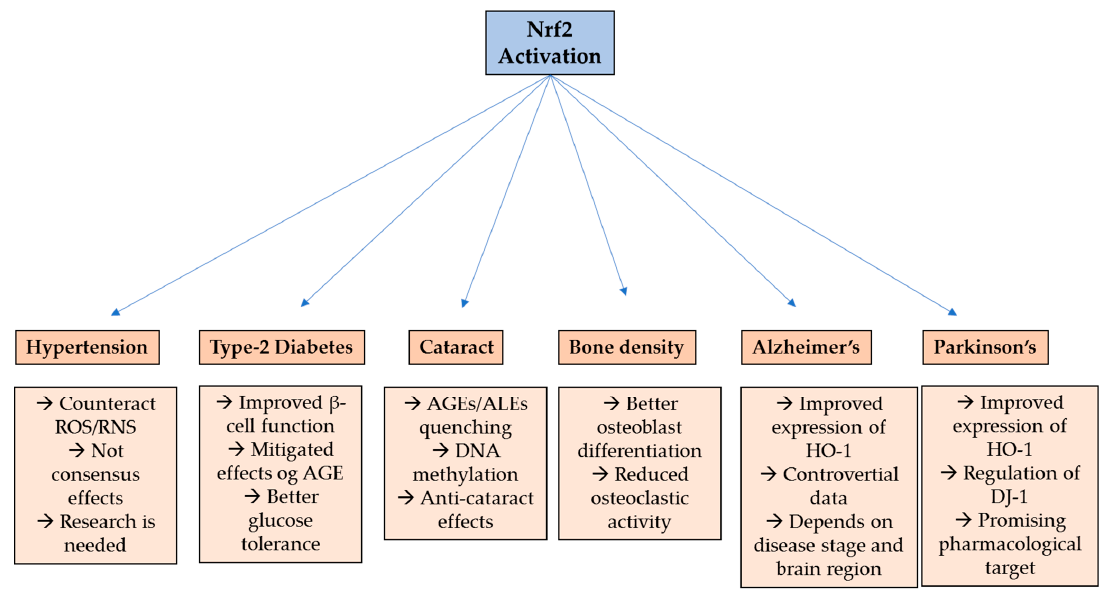
Figure 2. Nrf2 effect on age-related disorders. ROS—reactive oxygen species; RNS—reactive nitrogen species; AGE—advanced glycation end products; ALE—advanced lipoxidation end products; HO-1—heme oxygenase-1; DJ-1—protein deglycase.